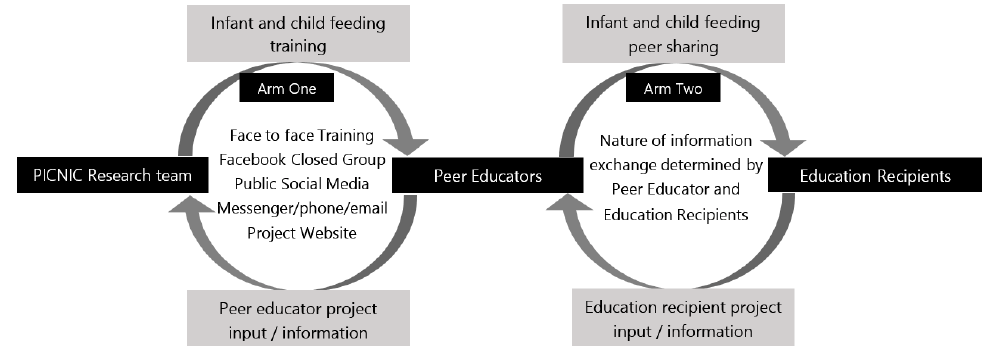
/ child nutrition and feeding information exchange in the PICNIC Figure 2. Infant/child nutrition and feeding information exchange in the PICNIC study. Figure 2. Infant